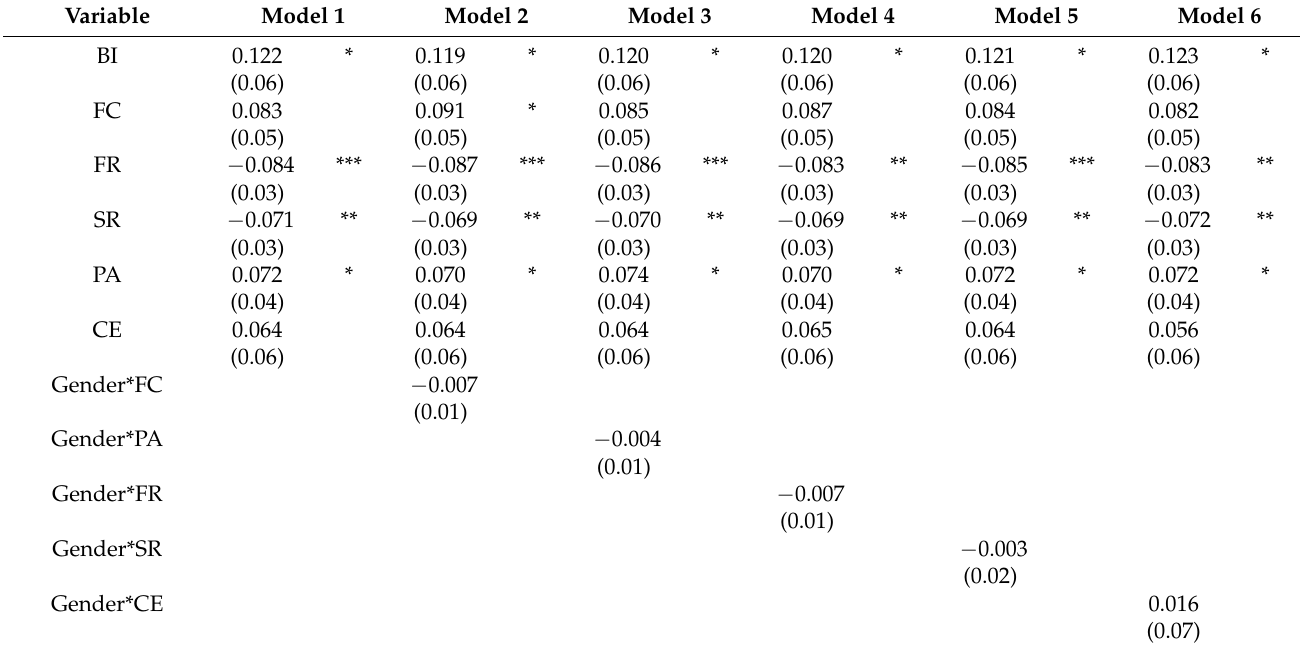
Table 7. The marginal effect estimates of the probit